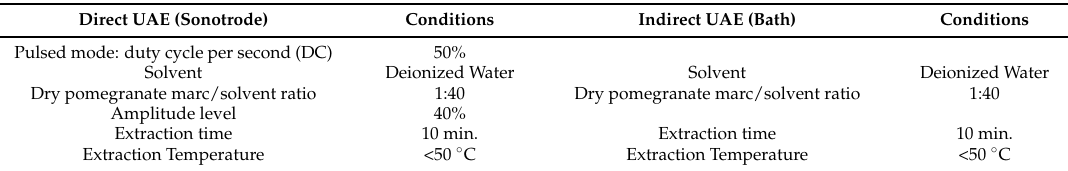
Table 4. UAE process condition